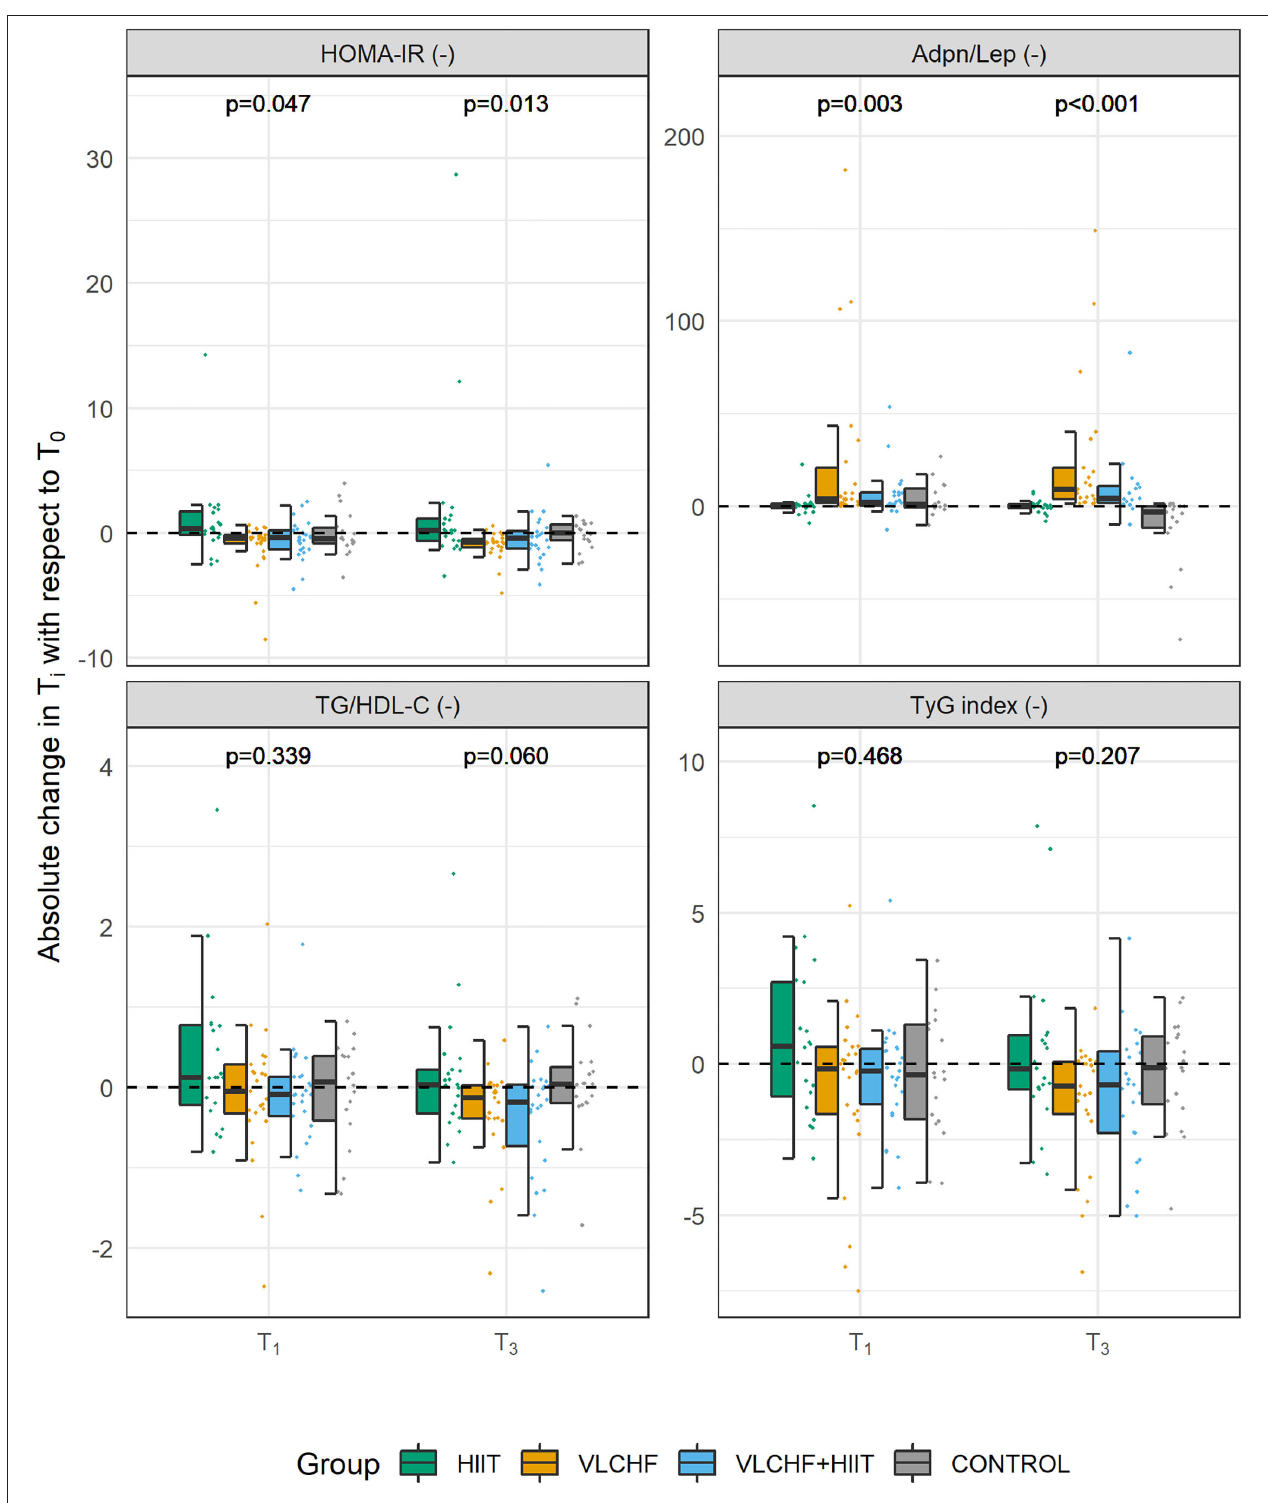
FIGURE 2 | Absolute changes in HOMA-IR, Adpn/Lep ratio, TG/HDL-C ratio, and TyG index after 4 (T 1 ) and 12 (T 3 ) weeks.